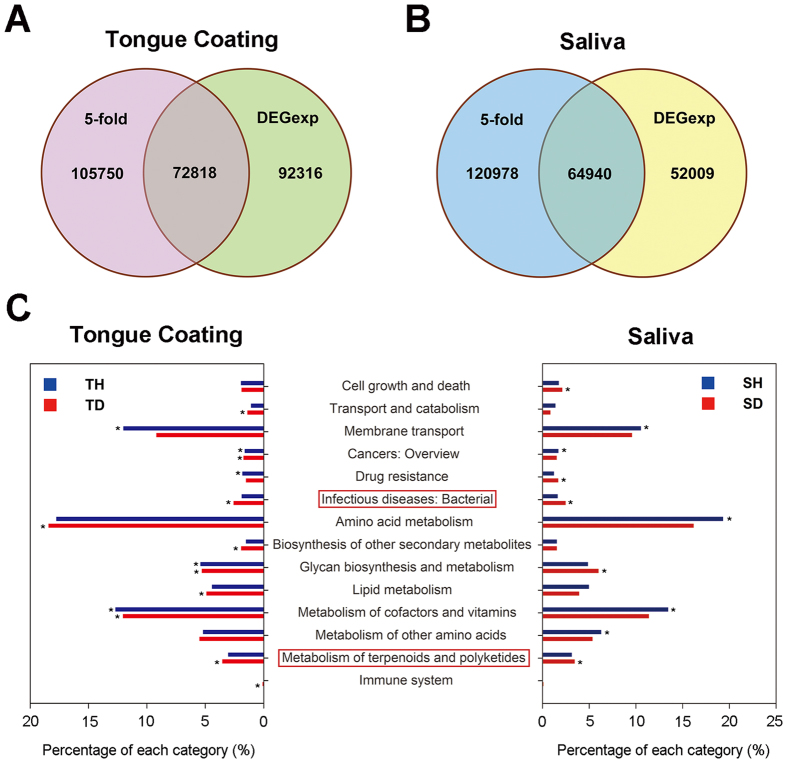
Comparisons of differential genes in tongue coating and saliva samples and enrichment of KO groups in tongue coating and saliva samples.(A) Genes with relative abundance differences of >5-fold and P-values < 0.001 in the DEGexp results were defined as differential genes in the tongue coating samples and are shown in the overlapping areas. (B) Differential genes in the saliva samples are shown. (C) KO enrichment groups in tongue coating and saliva samples are shown as percentages. Groups framed by a red box were enriched in both halitosis samples (tongue coating and saliva) but not in the healthy samples. *P < 0.05.